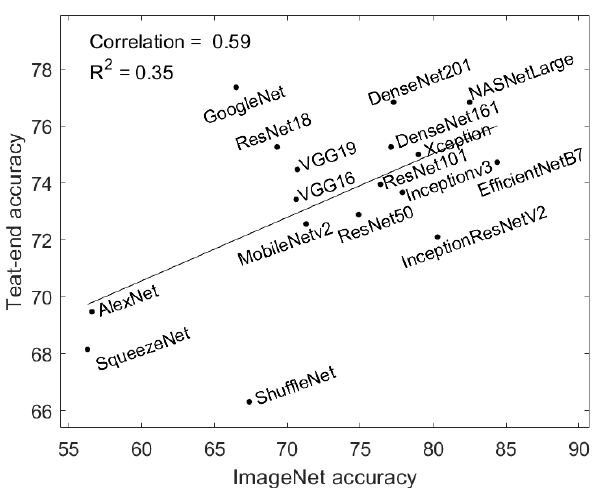
Figure 8. ImageNet models’ accuracy and teat-end classification accuracy. There is no strong relationship between them since both correlation and R 2 have a low